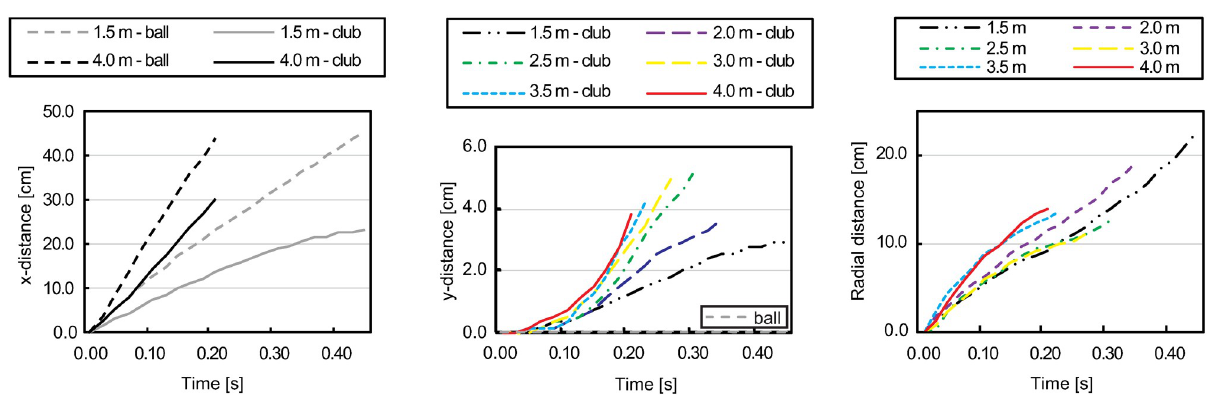
Fig 7. Schematic representation of stimuli in the follow-through phase. Left : Covered distance of ball and racket in x-direction after impact for putting distances 1.5 m and 4.0 m. Center : Covered distance of ball and racket in y-direction after impact for all putting distances. Right : Schematic representation of radial distance (rd) between club and ball. Note: Plots show real values measured with actual robot movements which were not perfectly smooth.